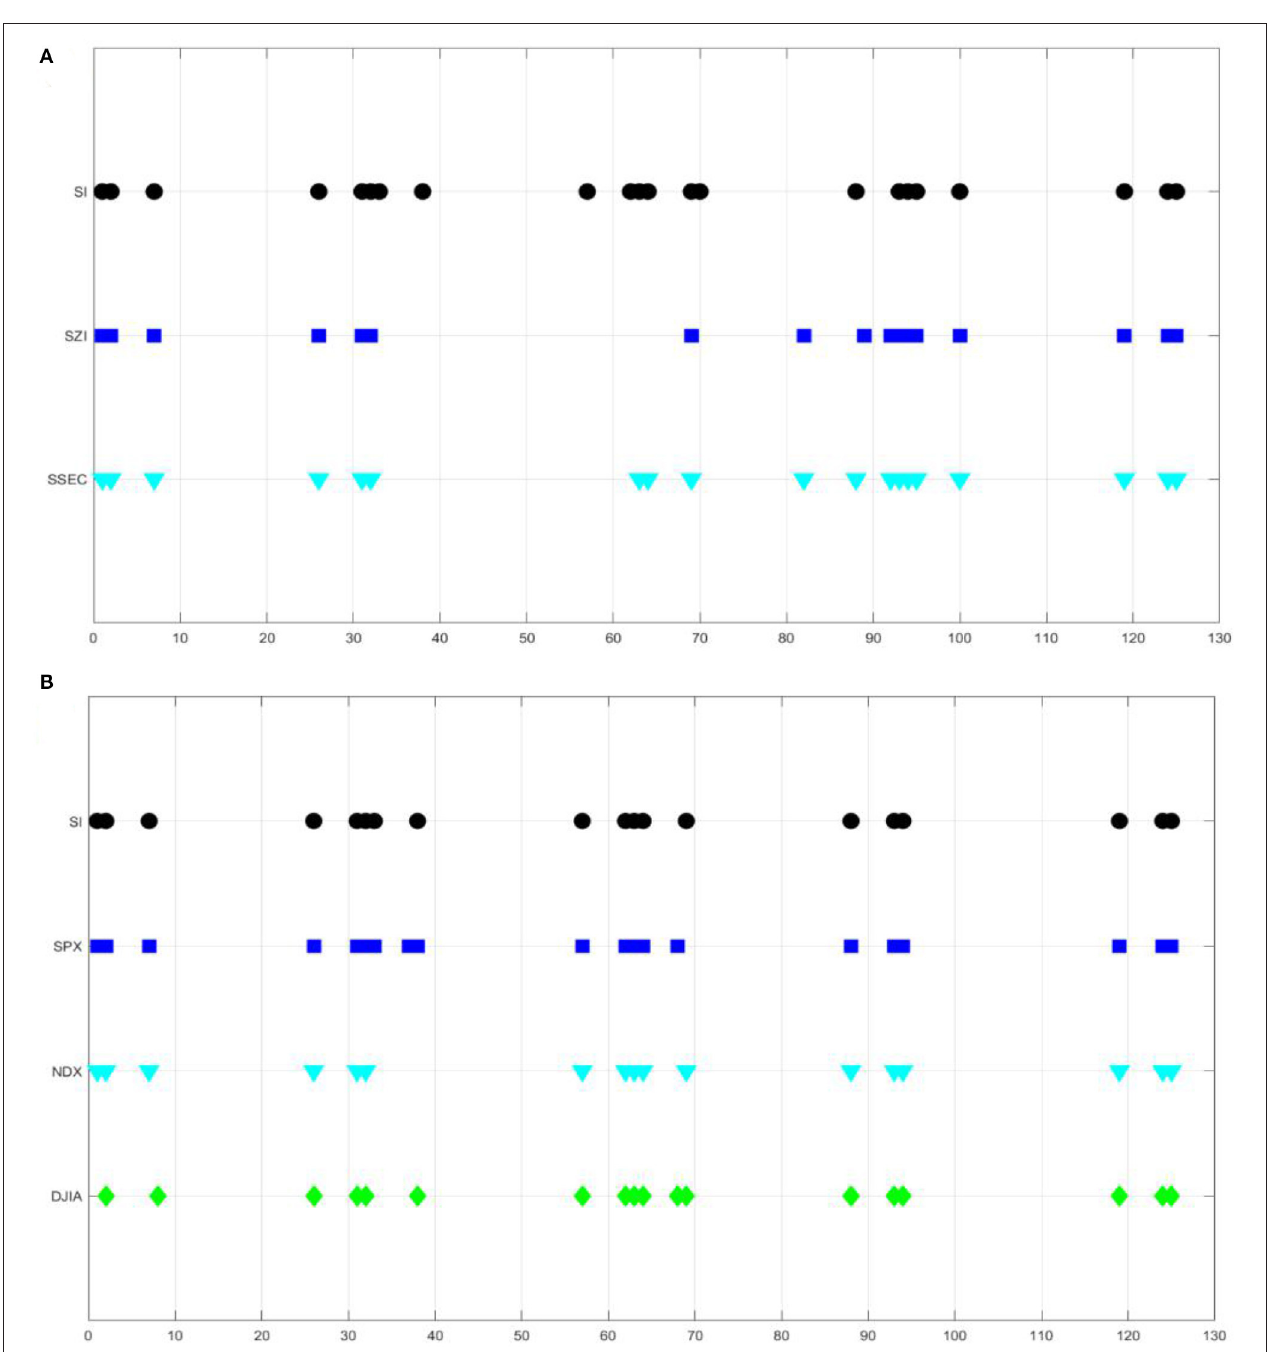
FIGURE 5 | Quantization distribution of stock market indexes and investor sentiment indexes for both China and U.S. in terms of a vector graph with sub statuses. (A) China investor sentiment index, SZI and SSEC. (B) U.S. investor sentiment index, SPX, NDX, and